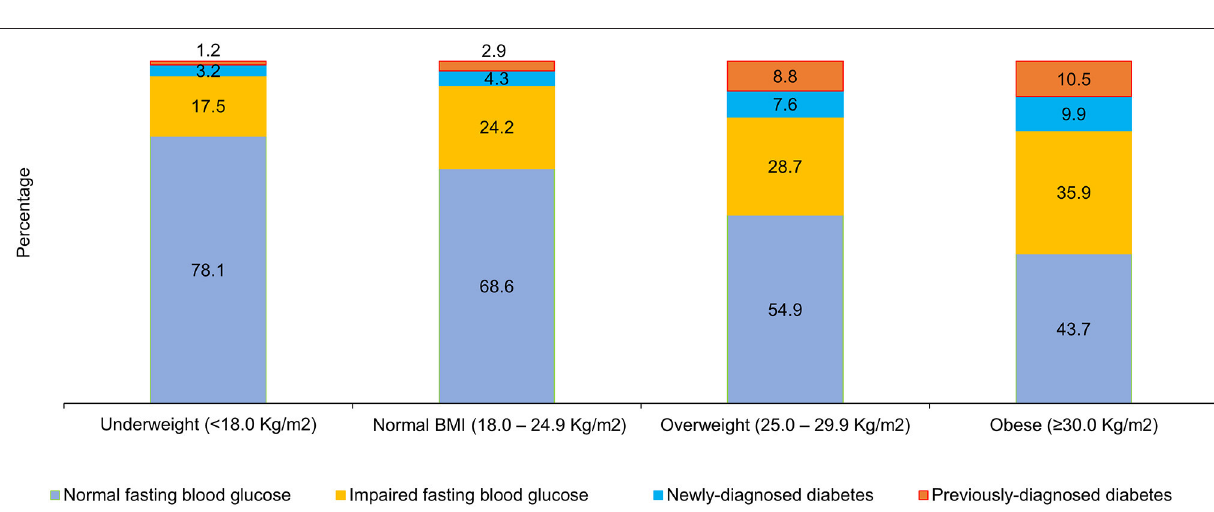
FIGURE 2 | Distribution (Percentage) of fasting blood glucose among adults by area of residence, sex and age categories.